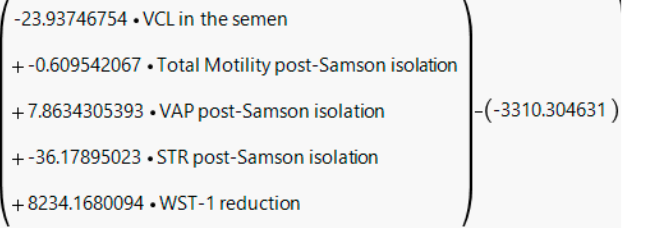
Figure A9. Equation optimized for stallion 3 from the post-chilled data set: predictive accuracy of 100%.